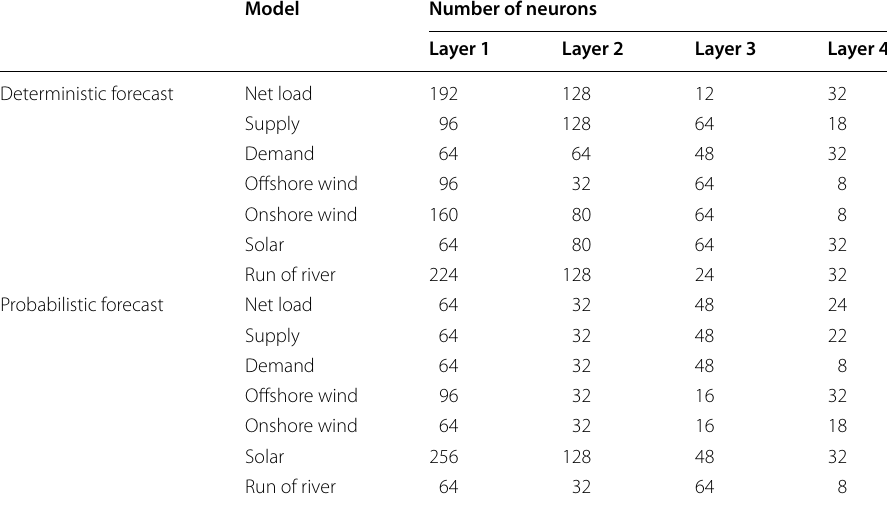
Table 3 Configuration of the best performing simple neural network forecasting models